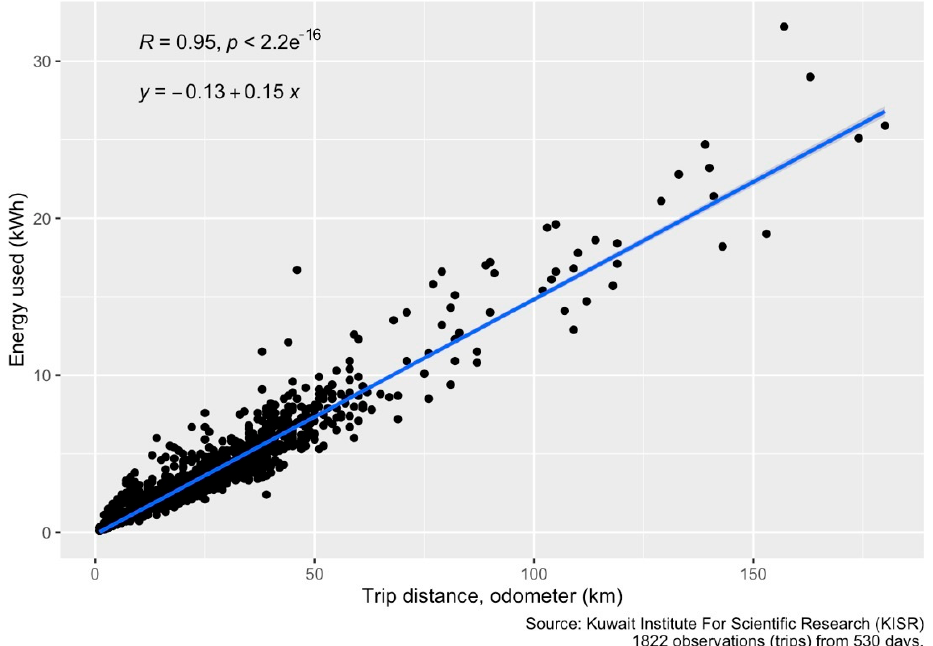
Figure 5. Electrical energy used against trip distance for each trip recorded.